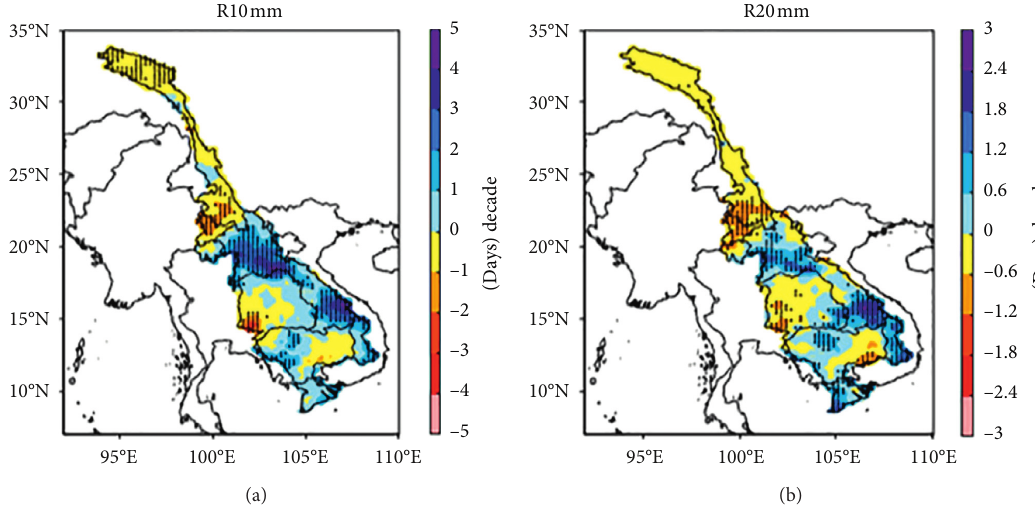
Figure 2: Spatial distribution of trend in R10mm and R20 mm in the MB over 1951–2015. The black dots indicate that the trend in the grid is significant ( p < 0 . 05) under the Mann–Kendall